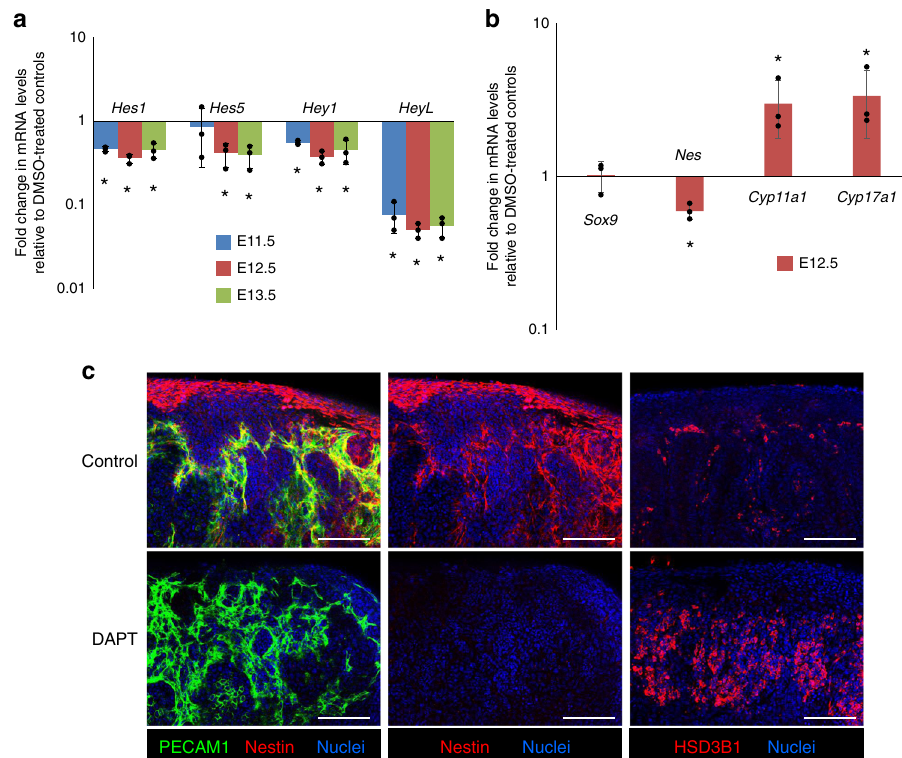
Fig. 8 Disrupting Notch signaling induces loss of Nestin -positive progenitors. a , b E11.5, E12.5, and E13.5 fetal testes were cultured with 100 µ M DAPT for 48 h and fold change in gene expression was calculated relative to their respective vehicle (DMSO)-treated control testes. a qPCR analysis showing fold change in expression of Notch target genes expressed in the fetal testis ( Hes1 , Hes5 , Hey1 , and HeyL ). b qPCR analysis showing fold change in expression of Sox9 (Sertoli cells), Cdh5 (endothelial cells), Nes (interstitial progenitors), and Cyp11a1 and Cyp17a1 (differentiated Leydig cells) after 48-h DAPT treatment of cultured E12.5 fetal testes relative to control cultured testes. Data are presented as the mean ± SD of 3 different biological replicates ( n = 3 litters, ≥ 5 gonads/litter). * P < 0.05 (two-tailed Student t -test). c Immuno fl uorescence of E12.5 fetal testes cultured in DMSO (Control) or 100 µ M DAPT for 48 h, showing loss of Nestin-positive cells and increase in HSD3B1-positive FLCs in DAPT-treated